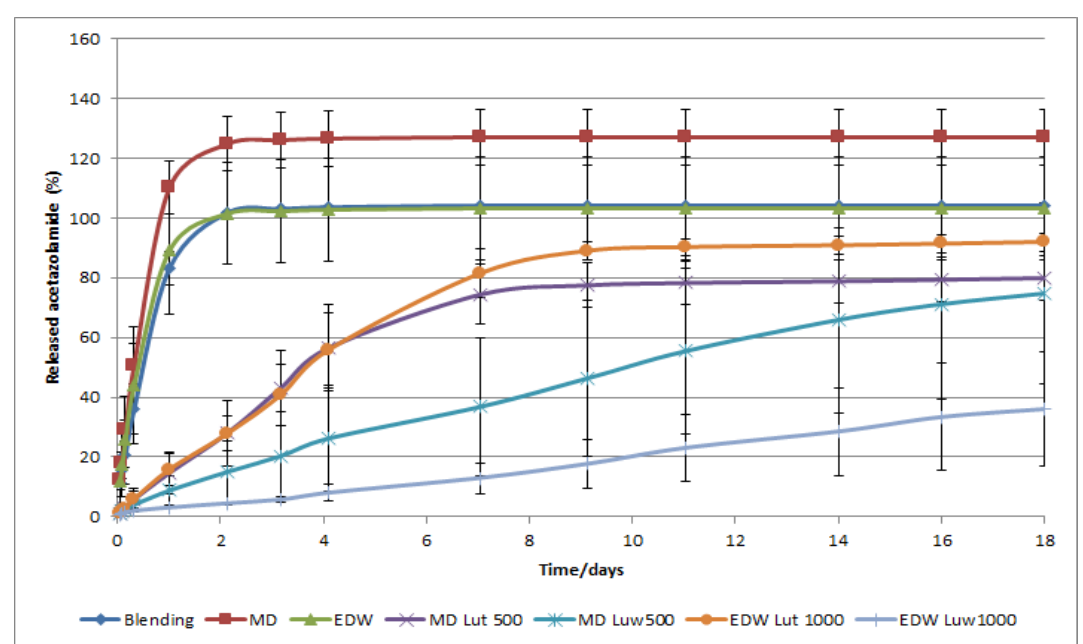
Figure 8. Percentage of drug release through time regarding implants with and without